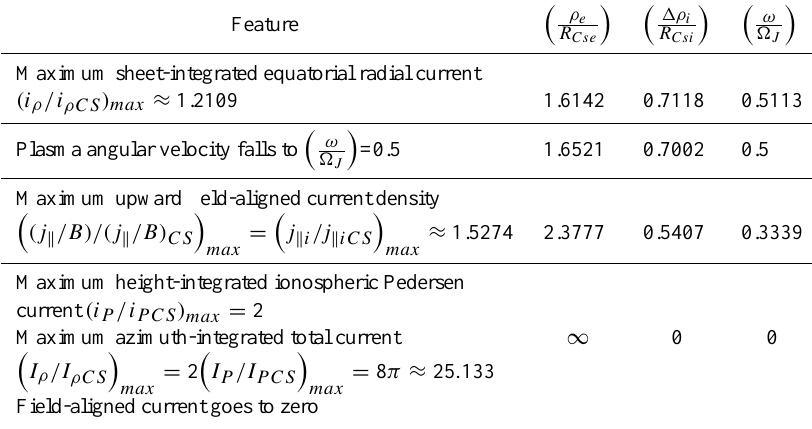
Table 3. Principal features of the plasma angular velocity and coupling current system for the power law current sheet field in normalised units, obtained (with m = 2 . 71) from the approximate analytic solution of Sect. 4